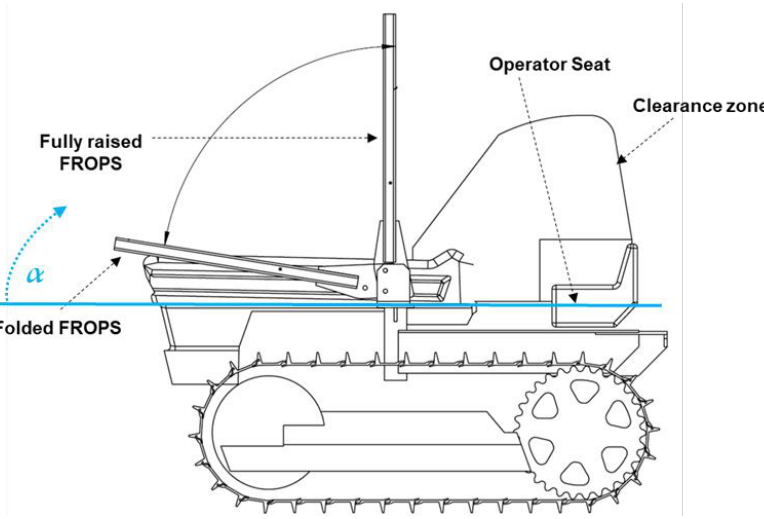
Figure 4. Scheme of the analyzed tractor ( α represents the folding angle of the FROPS).